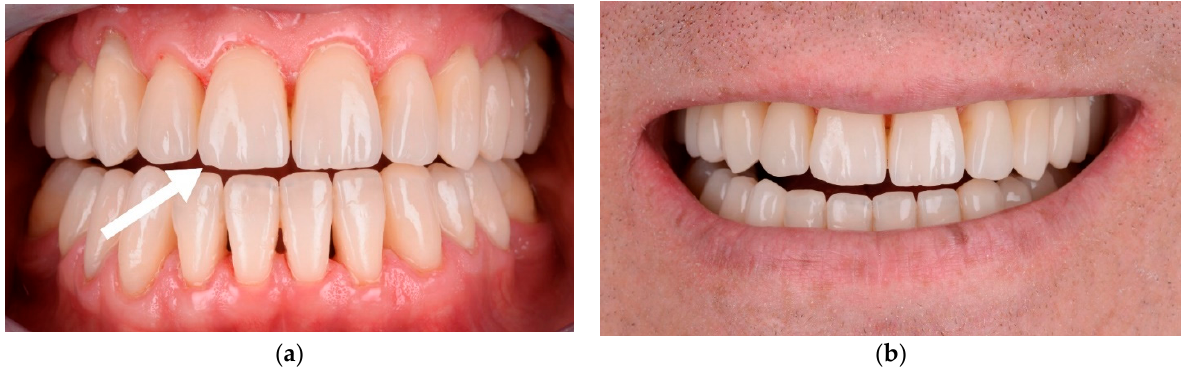
Figure 12. ( a ) Minor chipping on the central right upper incisor; ( b ) the chipping was managed by finishing and polishing.